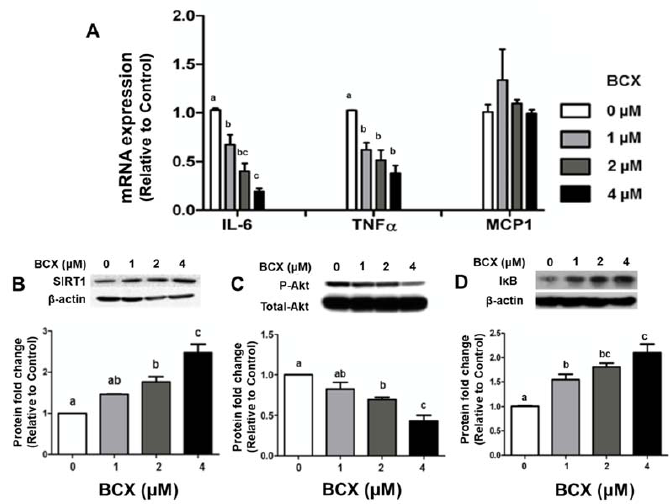
Figure 5. BCX treatment reduced inflammation, increased SIRT1 protein, and decreased phosphor- ylation of Akt in LPS-stimulated BEAS-2B cells. Shown are the graphical representations of mRNA expression of ( A ) IL-6, TNF- α , and MCP-1 quantified by real-time PCR. β -actin was used as a loading control. Protein expression levels of ( B ) SIRT1, ( C ) p-Akt, and ( D ) I κ B α were measured by Western blot in BEAS-2B cells pre-treated with BCX (0.5 to 4 µM) following LPS stimulation (10 ng/mL). β -actin and total-Akt were used as controls. Significant differences between groups were analyzed by one-way ANOVA and are denoted by different letters ( p < 0.05). BCX, β -cryptoxanthin; SIRT1, sirtuin 1; BEAS-2B, human bronchial epithelial cells; TNF, tumor necrosis factor; IL, interleukin; MCP-1, monocyte chemoattractant protein 1; SIRT1, sirtuin1; AKT, protein kinase B; I κ B α , nuclear factor of kappa light polypeptide gene enhancer in B-cells inhibitor, alpha; LPS,